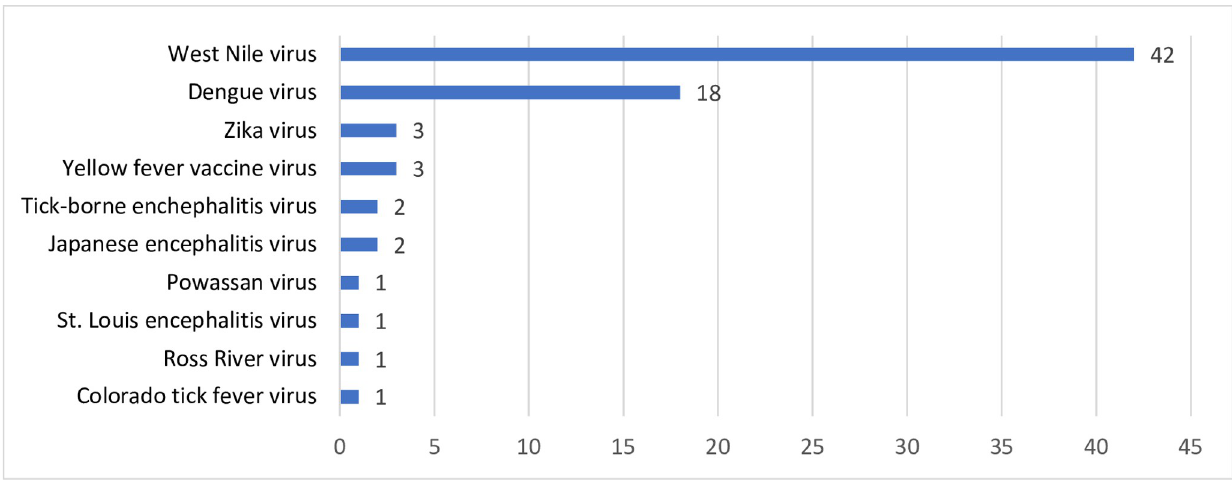
Fig 2. Reported transfusion-transmitted arbovirus cases.